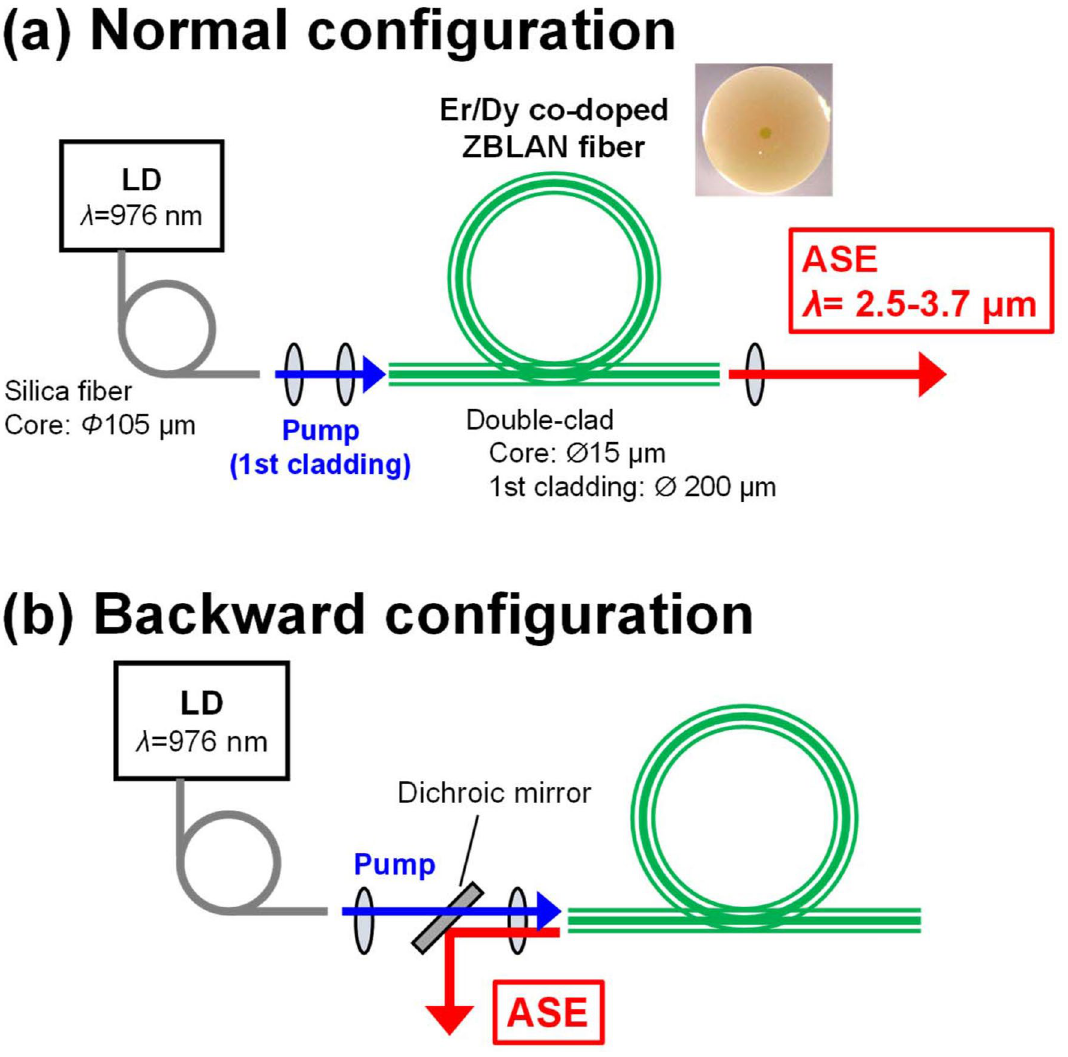
Figure 2. Experimental setup for mid-IR ASE light source. Er 3+ /Dy 3+ co-doped ZBLAN fiber is pumped by a 980-nm multimode diode source. ( a ) Normal configuration; ( b ) backward